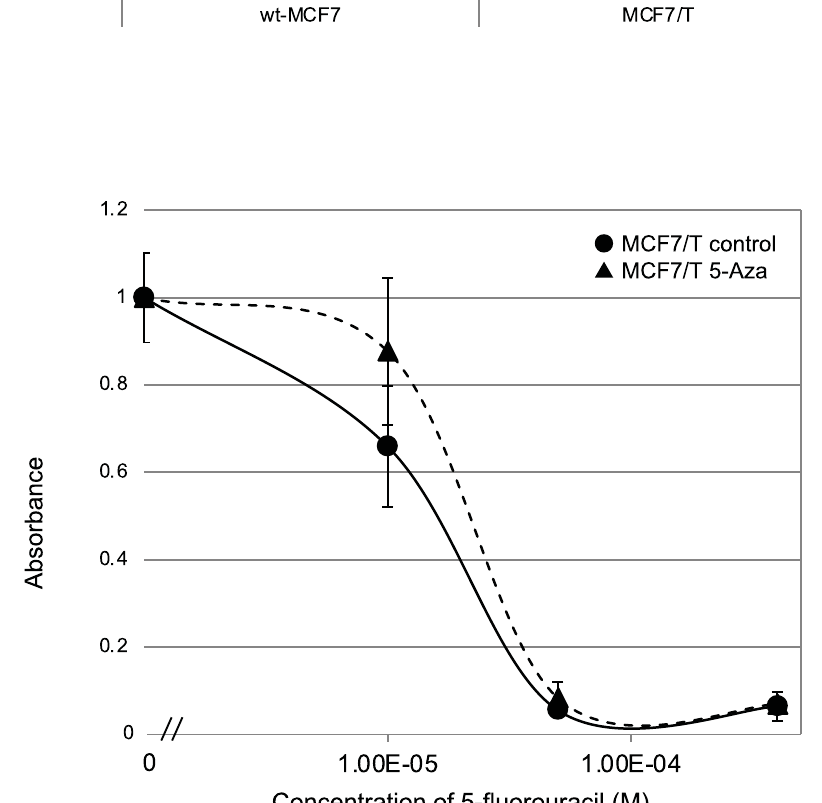
PLOS ONE | https://doi.org/10.1371/journal.pone.0252822 June 8,